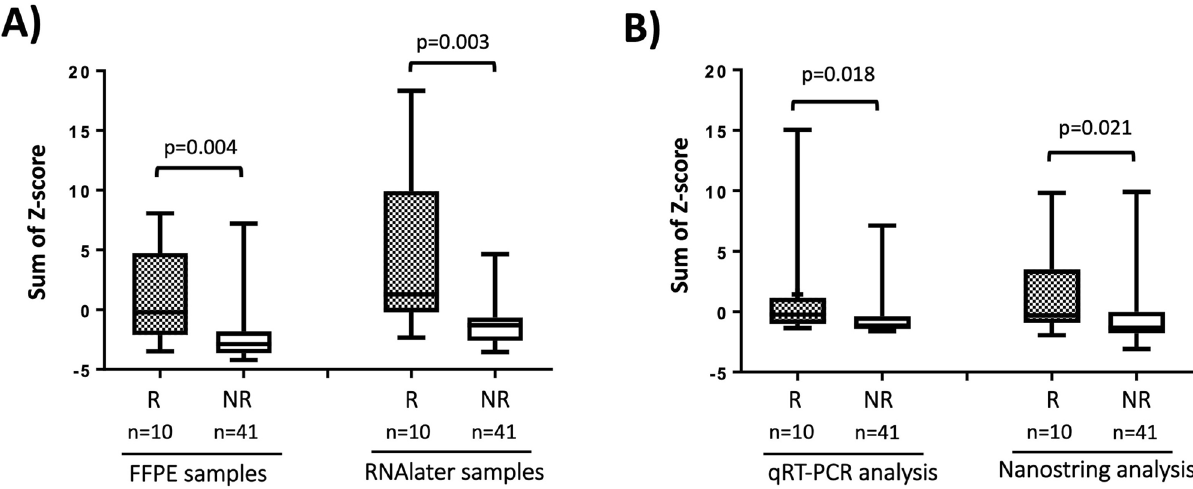
Figure 4. ( A ) Ability of NanoString analysis of FFPE and RNAlater samples to distinguish Rejection (R) from Non-rejection (NR); ( B ) ability of NanoString and qRT-PCR to differentiate R from NR in RNAlater preserved biopsies. Each box plot represents the distribution of the sum of Z-score for genes increased in rejection. Grey boxes represent 10 rejection samples (R) and white boxes represent 41 non-rejections samples (NR). ( A ) sum of z-score of 6 genes ( CCL4 , CXCL9 , CXCL10 , CXCL11 , IDO1 and PLA1A ) comparing FFPE and RNAlater samples from the same biopsy; ( B ) sum of z-scores of 4 genes ( CCL4 , CXCL10 , CXCL11 and PLA1A ) comparing qRT-PCR and NanoString on RNA from the same RNAlater sample. Significance determined using Mann Whitney